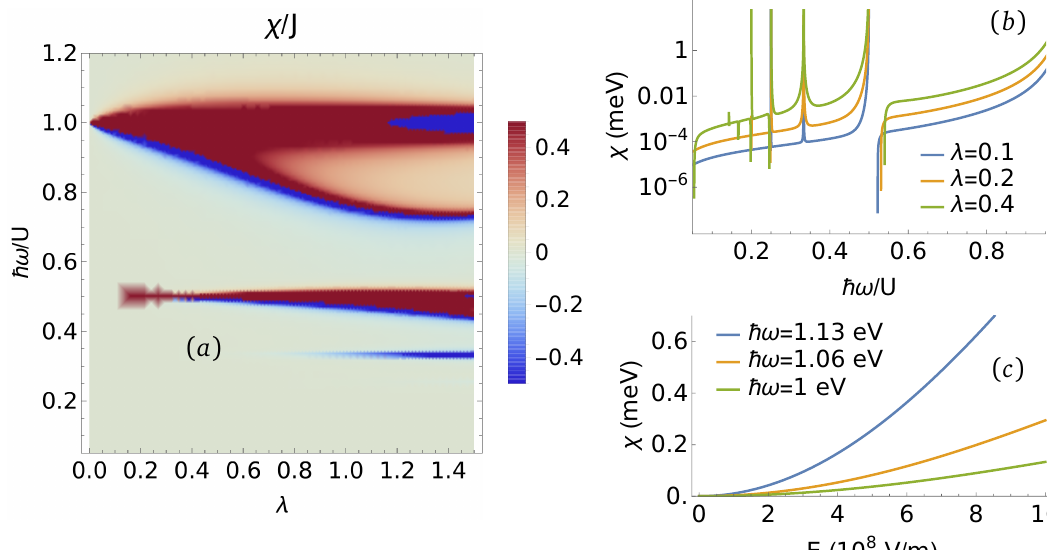
Figure 2: Energy scales of light-induced chirality. ( a ) Ratio of the synthetic scalar spin chirality χ to the field-renormalized Heisenberg exchange J as a function of field strength λ and photon energy (cid:126) ω . The results are for a system with t = 50 = 12 meV, giving an effective ferromagnetic exchange in meV, U = 1.25 eV and J D equilibrium of J = 4.0 meV and J (cid:48) = 13 µ eV. ( b ) χ as a function of photon energy (cid:126) ω for different values of the effective field strength λ . ( c ) χ as a function of electric field strength E for different values of the photon energy (cid:126) ω